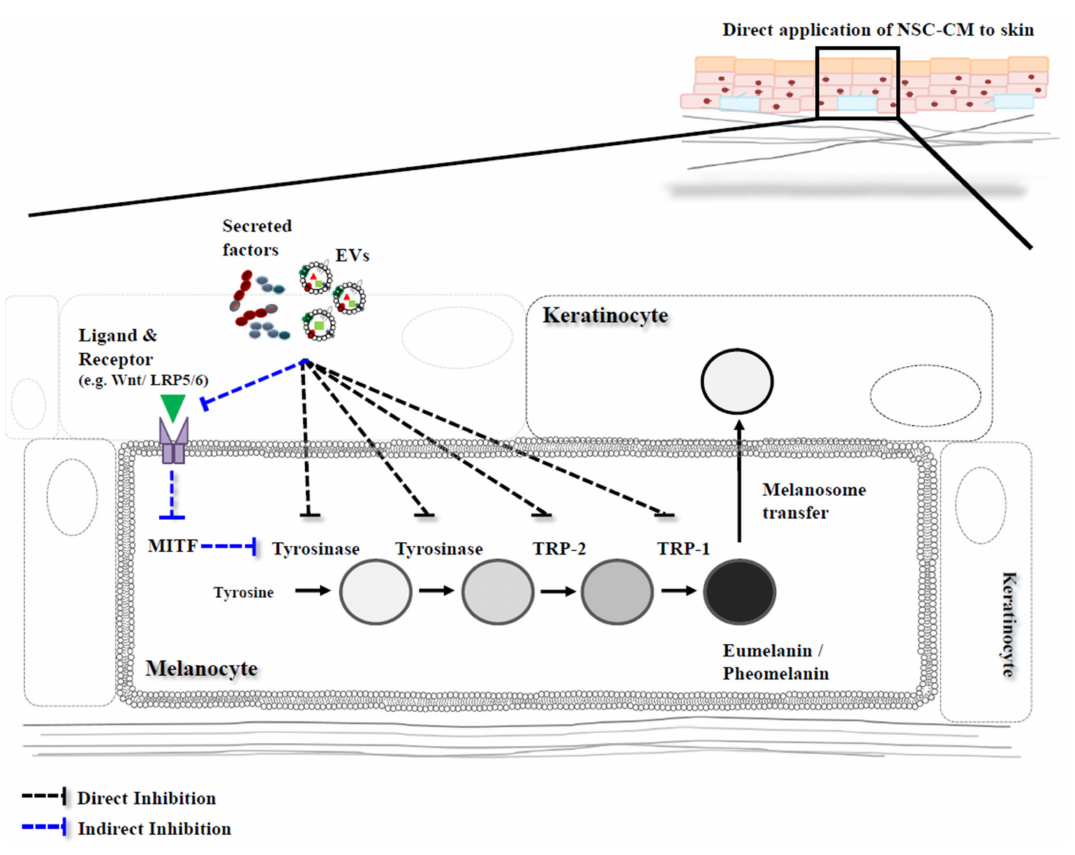
Figure 1. A schematic strategy inhibiting the pathways of melanin synthesis. The secreted factors and extracellular vesicles (EVs) including exosomes and microvesicles lead to multiple actions in a paracrine manner, which may be directly and/or indirectly involved in inhibiting the pathways of melanin synthesis. One is that the secreted factors and EVs directly regulate the expression of the melanogenic enzymes, the other one is that the secreted factors and EVs indirectly regulate the melanogenic genes via regulation of molecular signaling genes and subsequently MITF gene expression. NSC-CM, neural stem cells-conditioned medium. TRP-1, tyrosinase related protein-1 TRP-2, tyrosinase related protein-2. Microphthalmia-associated transcription factor ( MITF ) also plays a key role in regulating melanin synthesis pathways and all of the melanogenic enzymes are transcriptional targets of MITF . The promoters of tyrosinase ( TYR ), tyrosinase related protein-1 ( TRP-1 ) and tyrosinase related protein-2 ( TRP-2 ) genes, possess an MITF binding motif (5 (cid:48) -CATGTG-3 (cid:48) ). During melanocyte development, MITF directly regulates the expression of these melanogenic enzymes. The MITF gene and protein are not only initiated by a number of signaling pathways but are also regulated by transcriptional and post-transcriptional pathways. Furthermore, several transcription factors, Paired box protein (PAX3), cyclic adenosine monophosphate response element-binding (CREB), SRY-related HMG-box (SOX10) and lymphoid-enhancing factor/T-cell factors (LEF/TCF), bind to the MITF promoter and regulate its transcription. The melanocortin-1 receptor (MC1R) (ligand; α -melanocyte-stimulating hormone, α -MSH) involves the activation of cyclic adenosine monophosphate (AMP) and cyclic adenosine monophosphate response element-binding (CREB), which regulates MITF . Along with the MC1R pathway, the tyrosine kinase receptor c-kit (ligand; stem cell factor, SCF) signaling pathway, stimulates mitogen-activated protein kinase (MAPK) and modulates MITF . Additionally, the Wnt/ β -catenin pathway, Frizzled proteins and lipoprotein-receptor-related proteins 5 and 6 (LRP5/6) (ligand; Wnt), regulate transcription of MITF through interactions with LEF/TCF, which stabilize cytoplasmic β -catenin and transport it into the